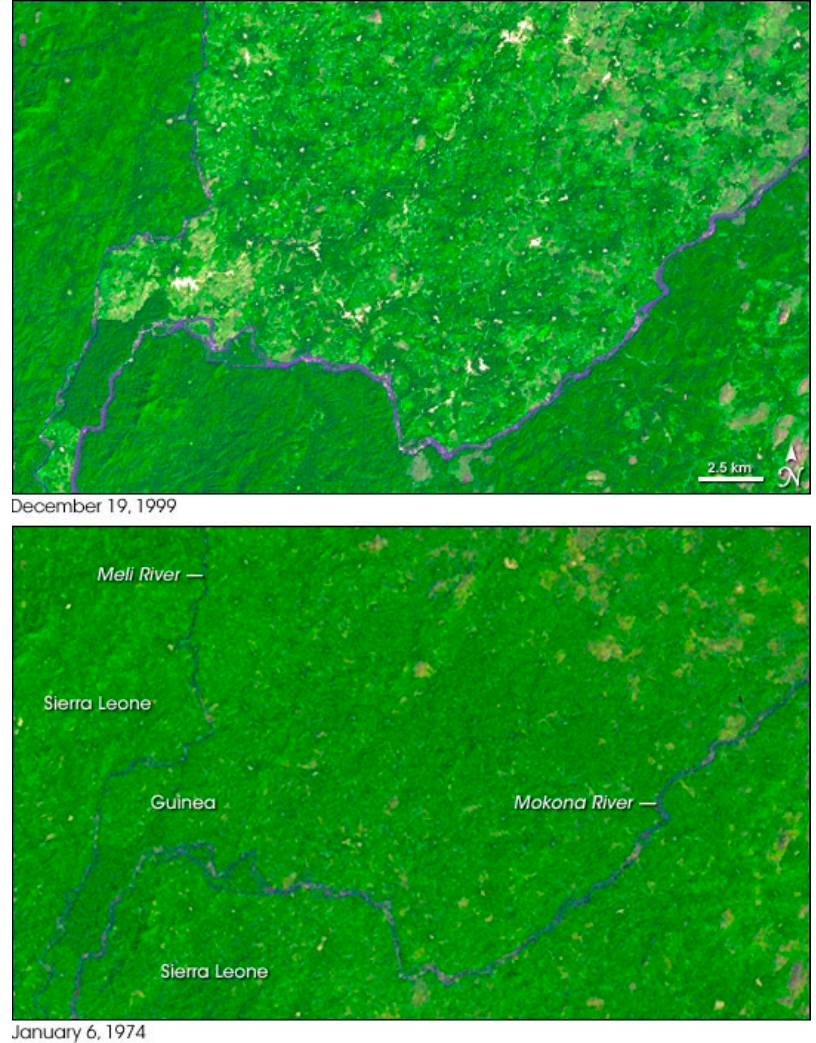
Figure 1. Deforestation in Guinea’s Parrot’s Beak Area. This pair of Landsat satellite images illustrates the deforestation that took place between December 19,1999 (top), and January 6, 1974 (bottom). In 1974, deep green forests covered much more of the region than they did in 1999. Source: NASA’s Earth Observatory, https://earthobservatory.nasa.gov/images/6450/deforestation-in-guineas-parrots-beak-area (accessed on 19 February 2021).